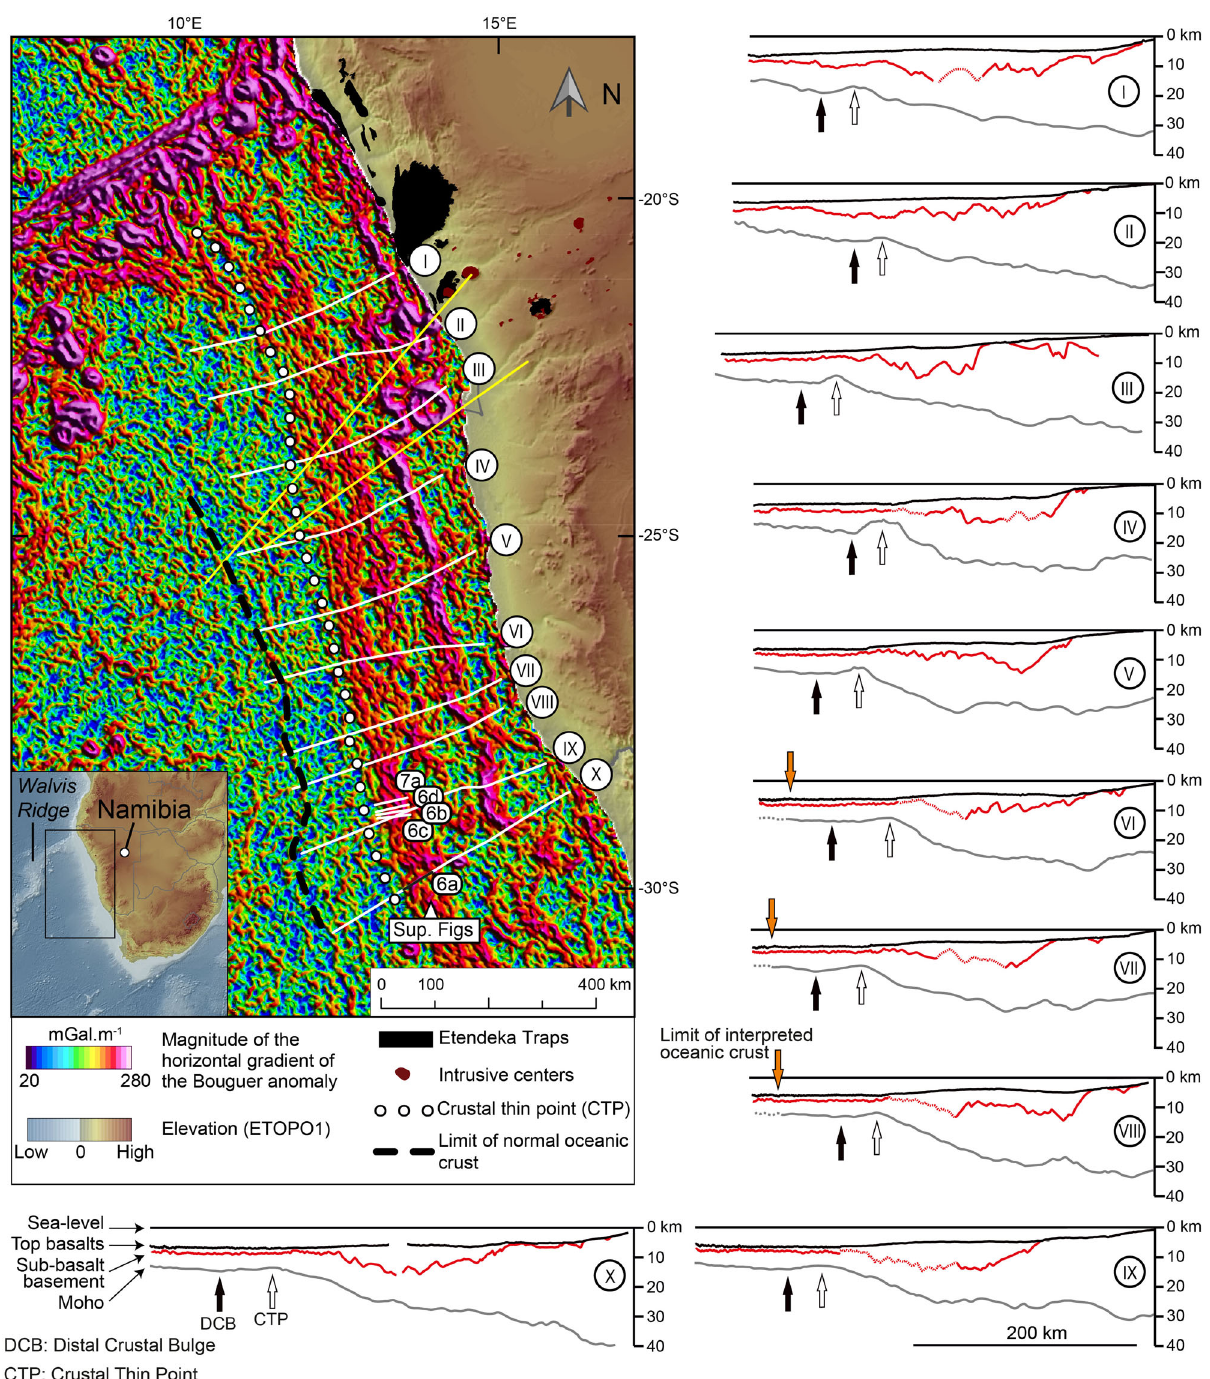
Fig. 2 Location of the seismic lines on a gravity map and crustal-scale line drawing. Left: horizontal gradient magnitude of the Bouguer anomaly along the Namibia margins. Magnetic anomalies in Supplementary Fig. 1. Numbers I – X refer to the seismic lines that we used (NamibiaSPAN TM from ION TM ). Information about the depth conversion of time lines is found in Supplementary Figs. 2 and 3. Yellow: seismic refraction lines 21 . Right and bottom: simpli fi ed line drawings from depth-converted